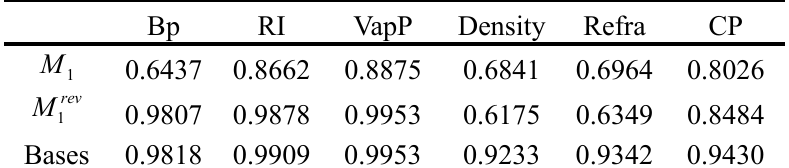
Table 5. R-values between M and the